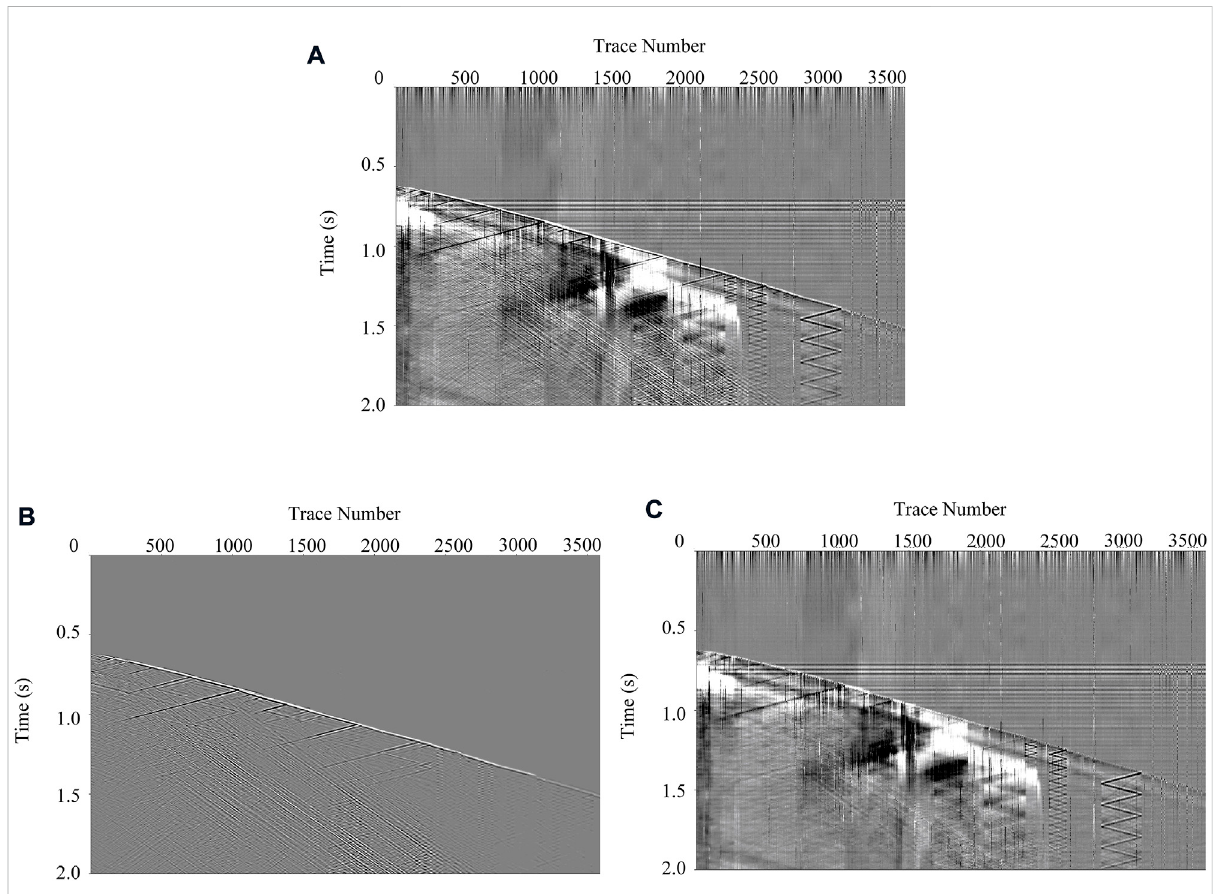
FIGURE 13 The denoising result of another fi eld DAS-VSP record. (A) The new fi eld DAS-VSP data. (B) The denoising results for the proposed method. (C) The predicted noise of the proposed